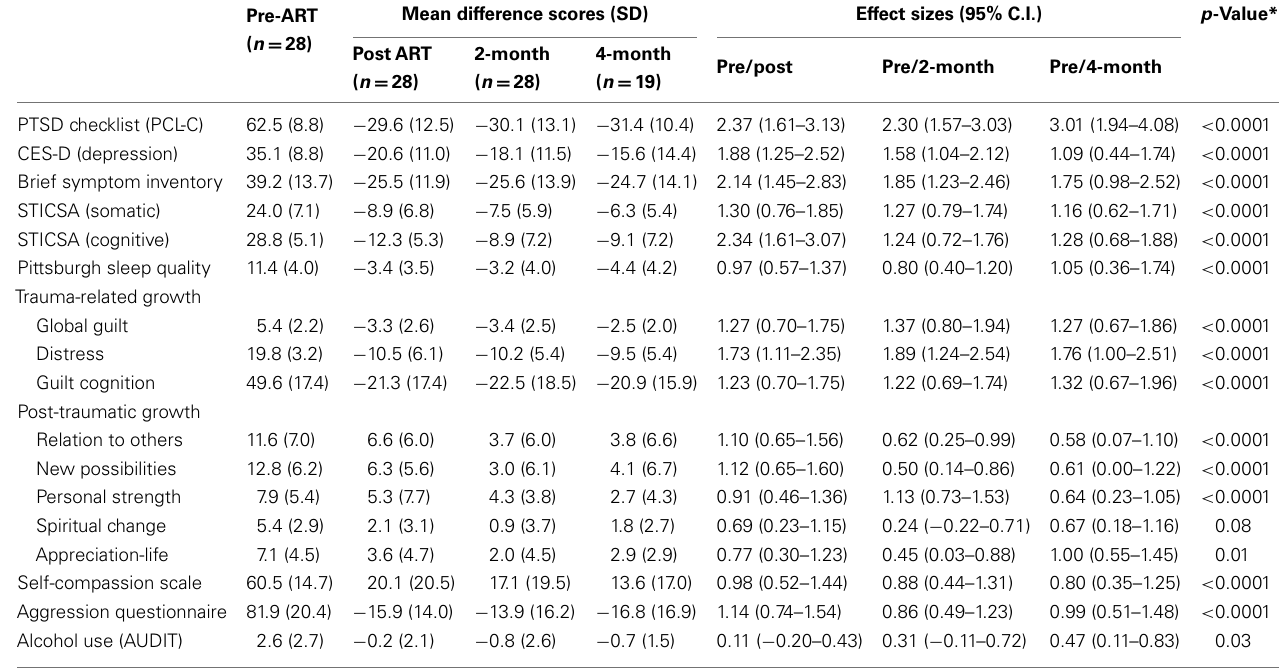
Table 3 | Mean outcome difference scores and effect sizes from pre-treatment to post-treatment, and 2- and 4-month follow-up.